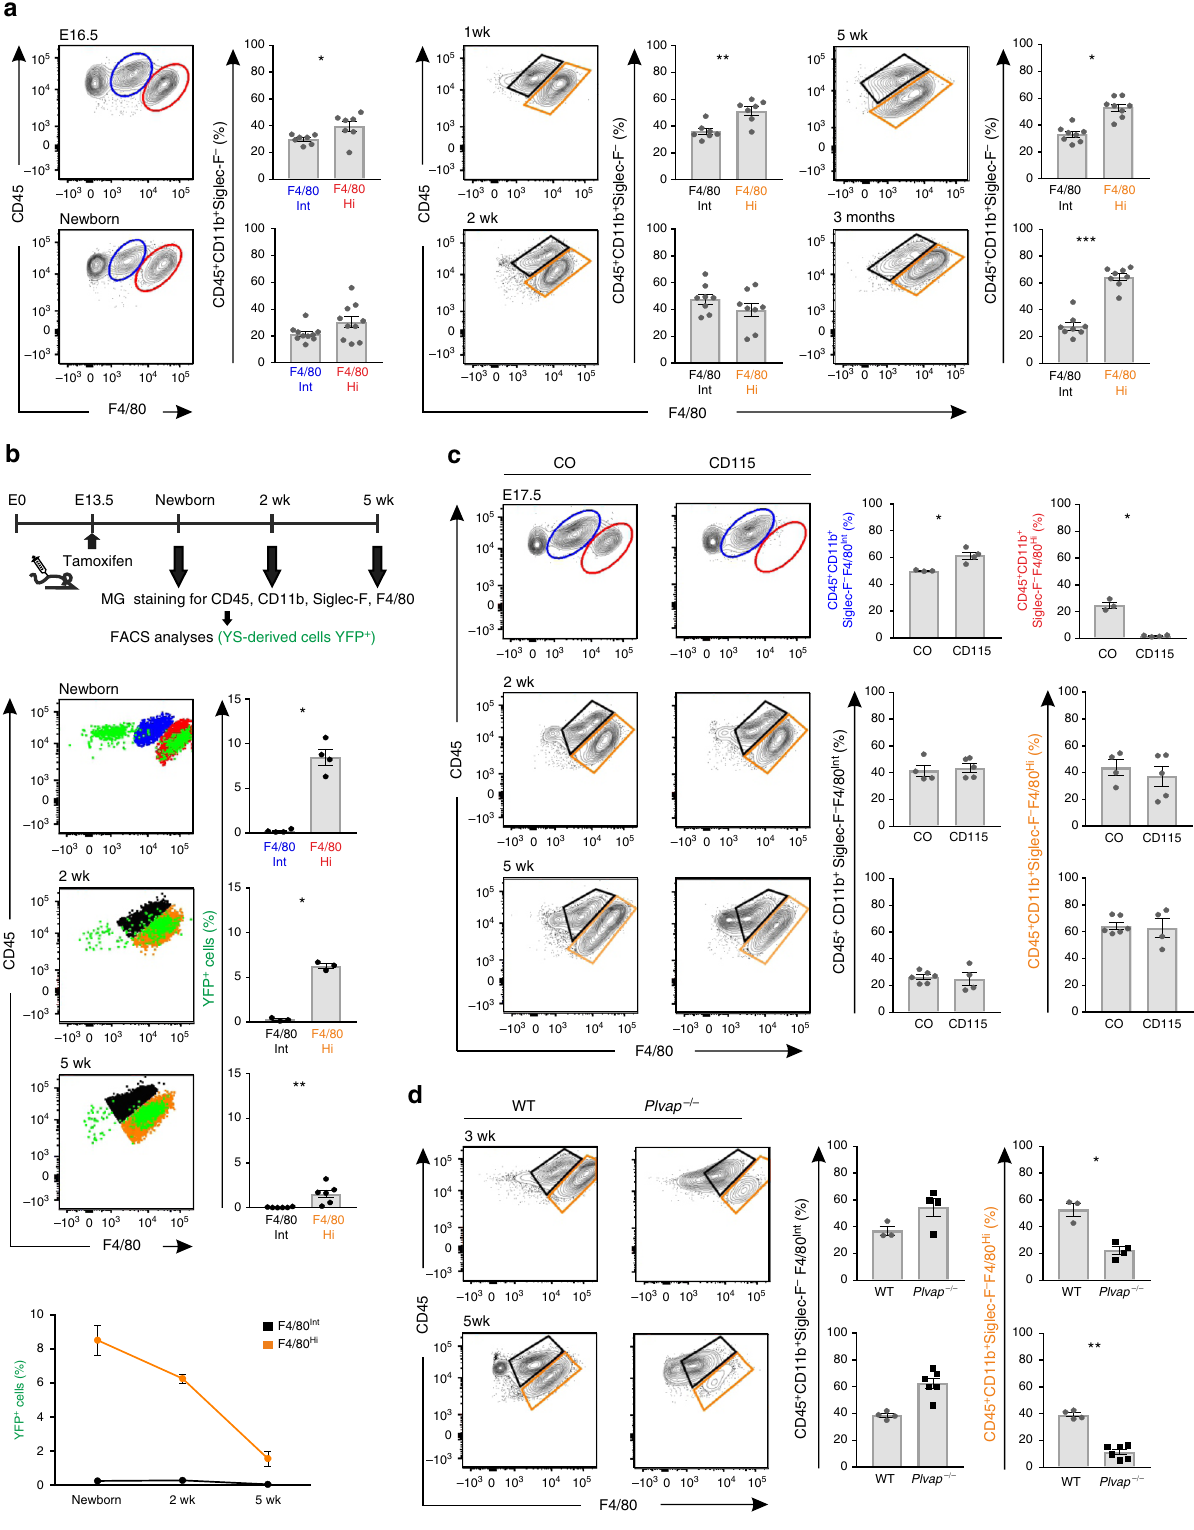
E0 E13.5 Newborn 2 wk 5 wk